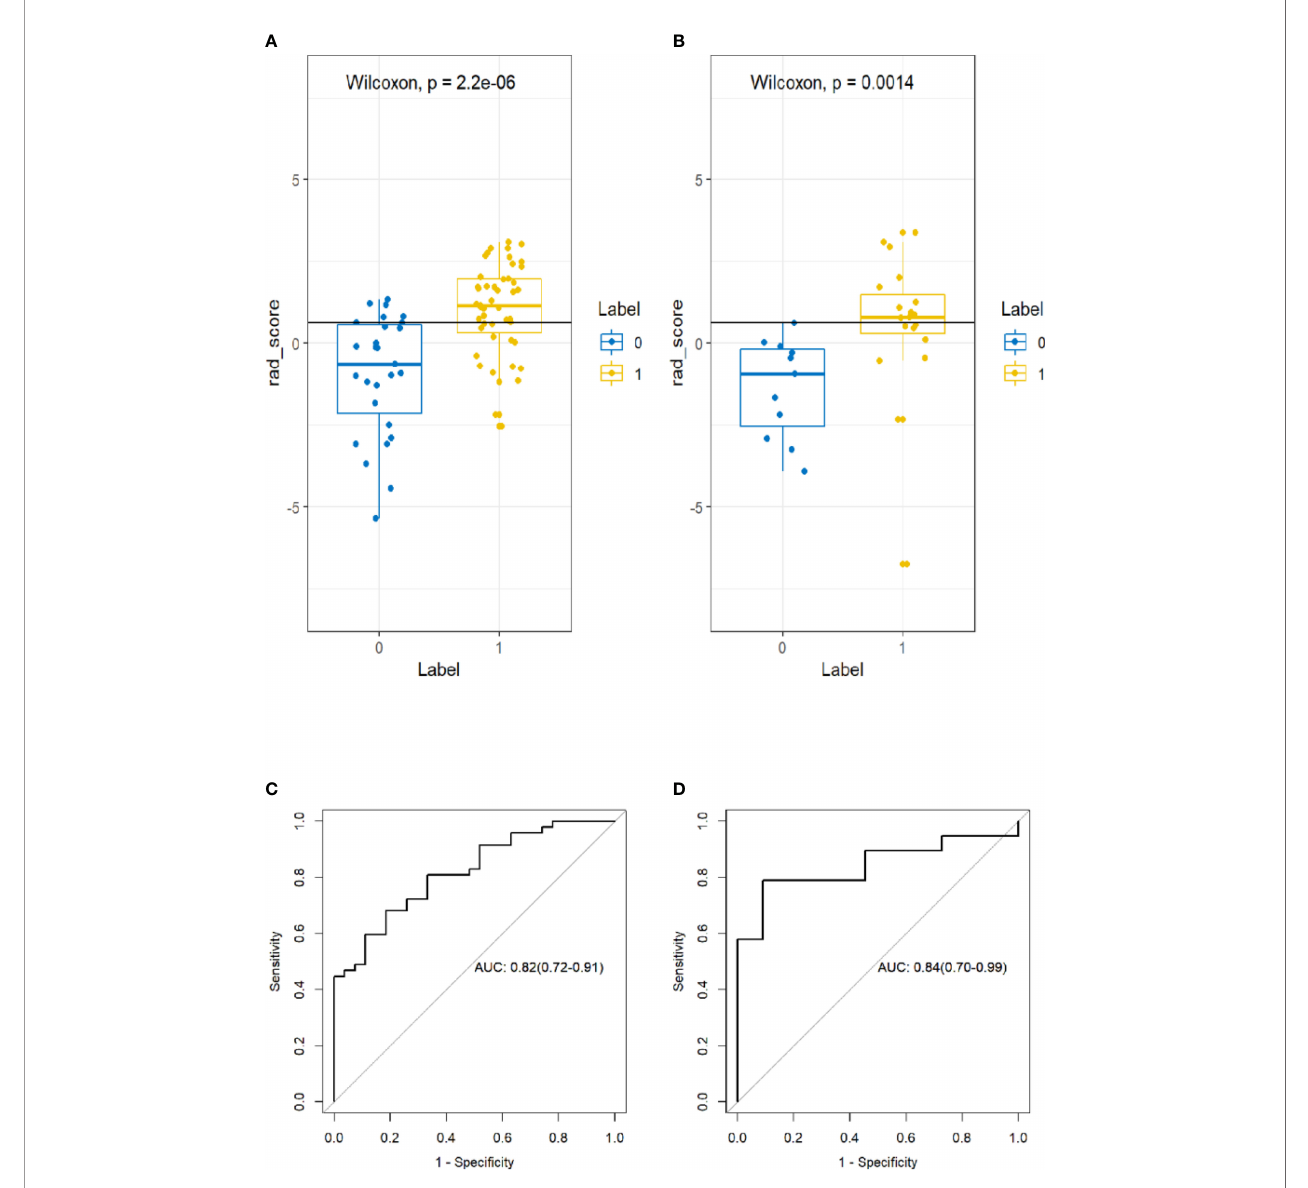
FIGURE 3 | Box plot showing the rad-score distribution of incomplete ablation and complete ablation on training and validation cohorts. p-value from Wilcoxon Rank-Sum test (A, B) . Receiver operator characteristic (ROC) curves (training and validation cohorts) (C, D) . The prediction performance of the ROC curves for radiomics signature for training and validation